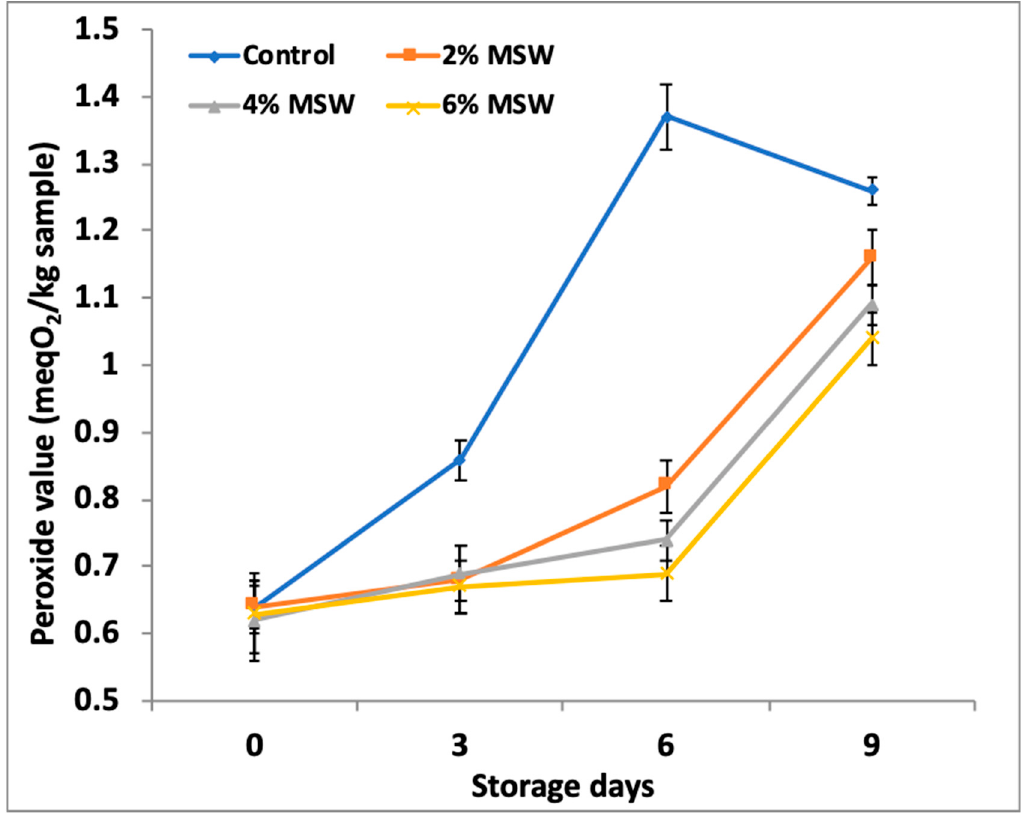
Figure 1. Effect of mushroom stem waste (MSW) powder on peroxide values of goat meat nuggets during storage.